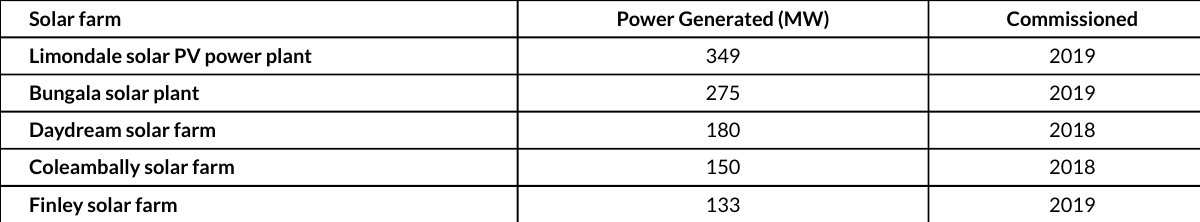
Table 9. The largest five solar farms in